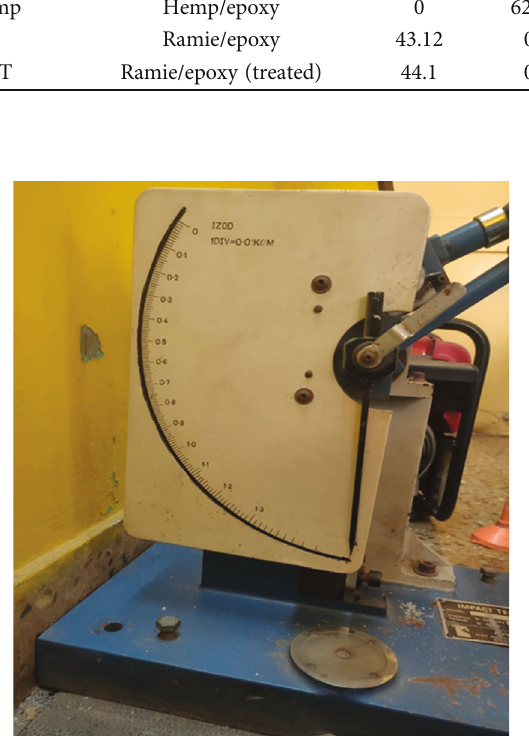
Figure 2: Shows the schematic view of impact testing